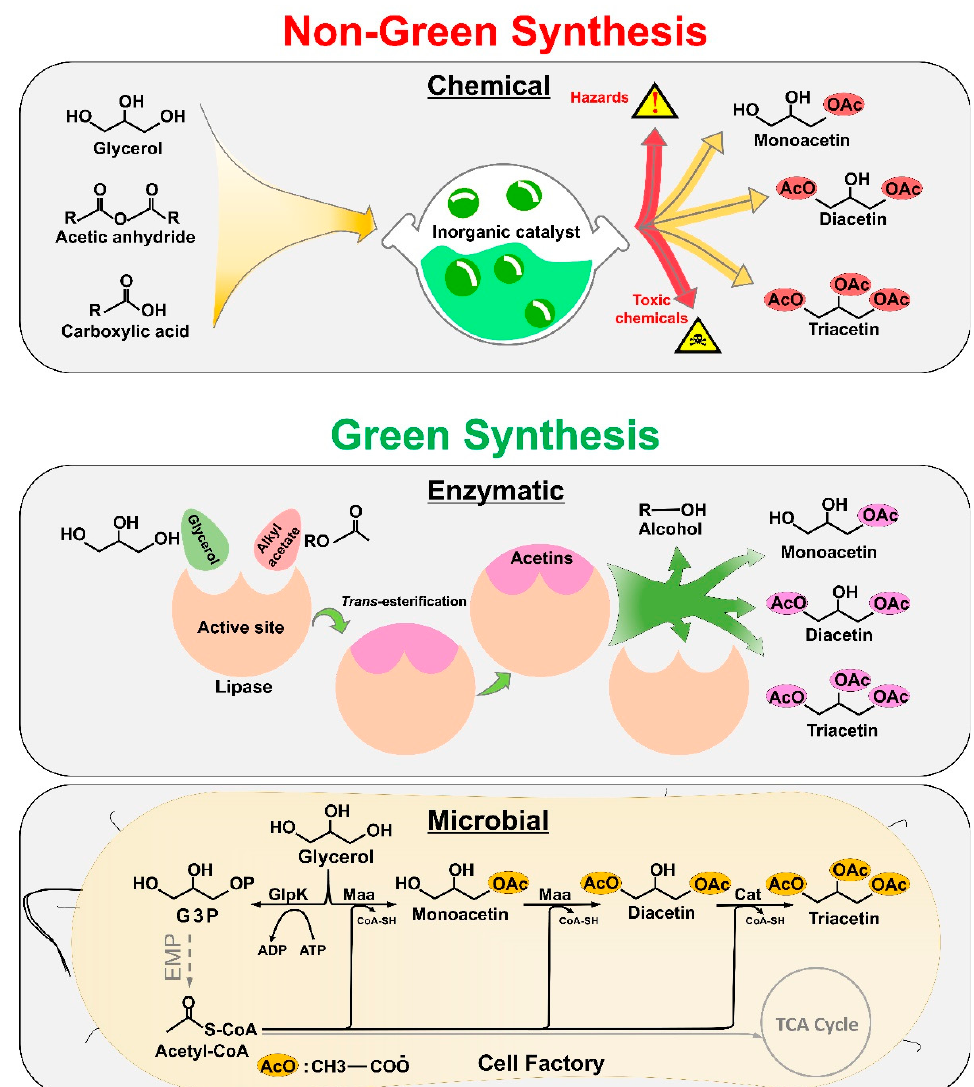
Figure 1. Acetins synthesis by “green” and “non-green” methods. The non-green synthesis of acetins involves traditional chemical methods that use inorganic catalysts (upper panel). The green synthesis of acetins involves enzymatic and microbial methods (middle and lower panel). The abbreviations are as follows: OAc, acetate group; Maa, maltose O -acetyltransferase; Cat, Chloramphenicol O -acetyltransferase.